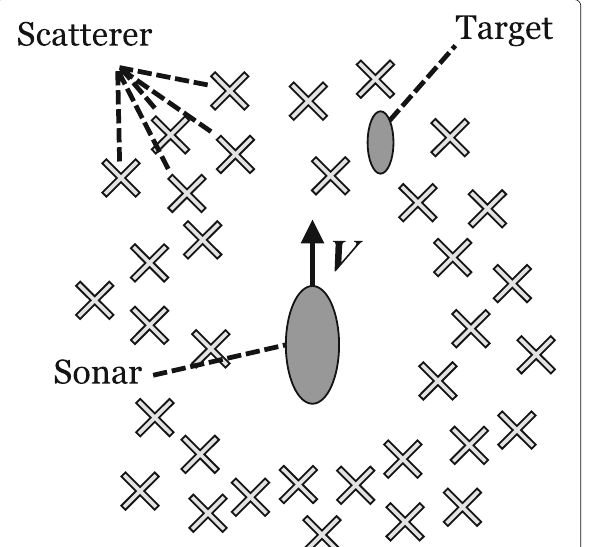
Fig. 1 Problem scenario. A moving receiver should detect a low-Doppler target among scatterers where a is an attenuation factor, t d is time delay, and j is the unit imaginary number. The frequency of s e ( t ) is